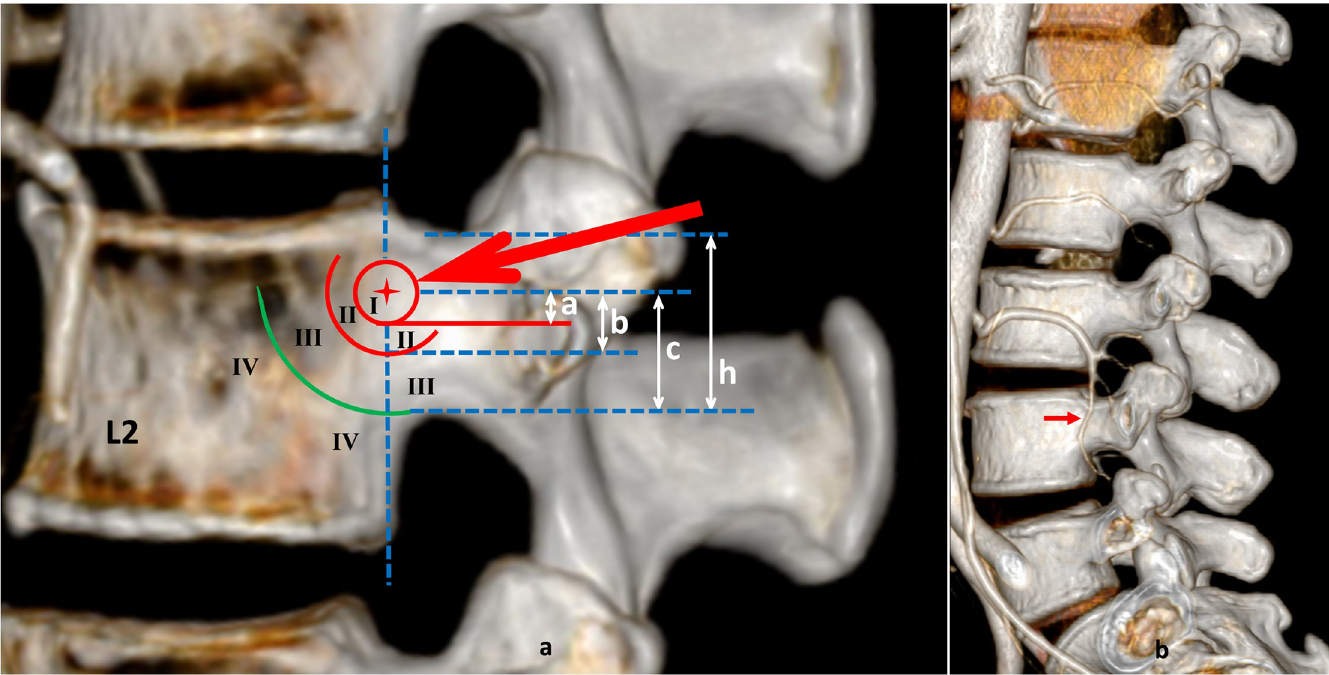
Fig 1. Zone I-IV in the posterolateral side of the vertebral body and intersegmental branch. a, circle: the vertebral body puncture point, diameter 5 mm. Arrow: puncture path. h: the sagittal pedicle isthmus width. Longitudinal dashed line: L2 vertebral body posterior border. Horizontally dashed lines: dividing h into 3 equal parts. a = 0.25 mm, b = 5 mm, c = 10 mm, h = 15 mm. I, II, III and IV represent Zone I, Zone II, Zone III and Zone IV, respectively. b, the intersegmental branch in L4 that originated from the left 3 rd LA and longitudinally passed through the lateral wall of the L4 left pedicle.